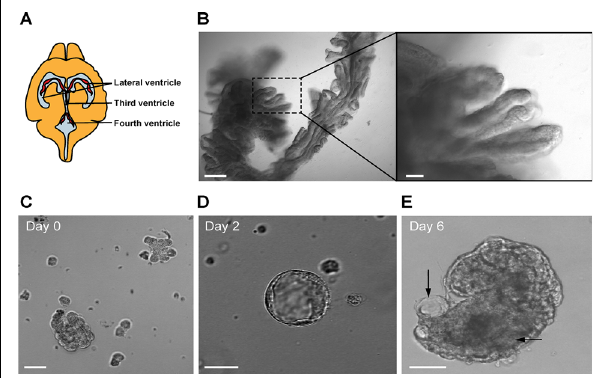
FIGURE 1 | (A) Location of the choroid plexus (CP) in the ventricles of the mouse brain. (B) Mouse CP excised from the lateral ventricles (bar 100 µ m). The right panel shows a magnified view (bar 20 µ m). (C) Fragments of CP after trypsin digestion. Representative image of a primary CP cell cluster in Matrigel at day 0 (bar 50 µ m). (D) Example of a small CP explant at day 2 (bar 20 µ m). (E) Example of a CP explant at day 6 (bar 20 µ m). Arrows show luminal